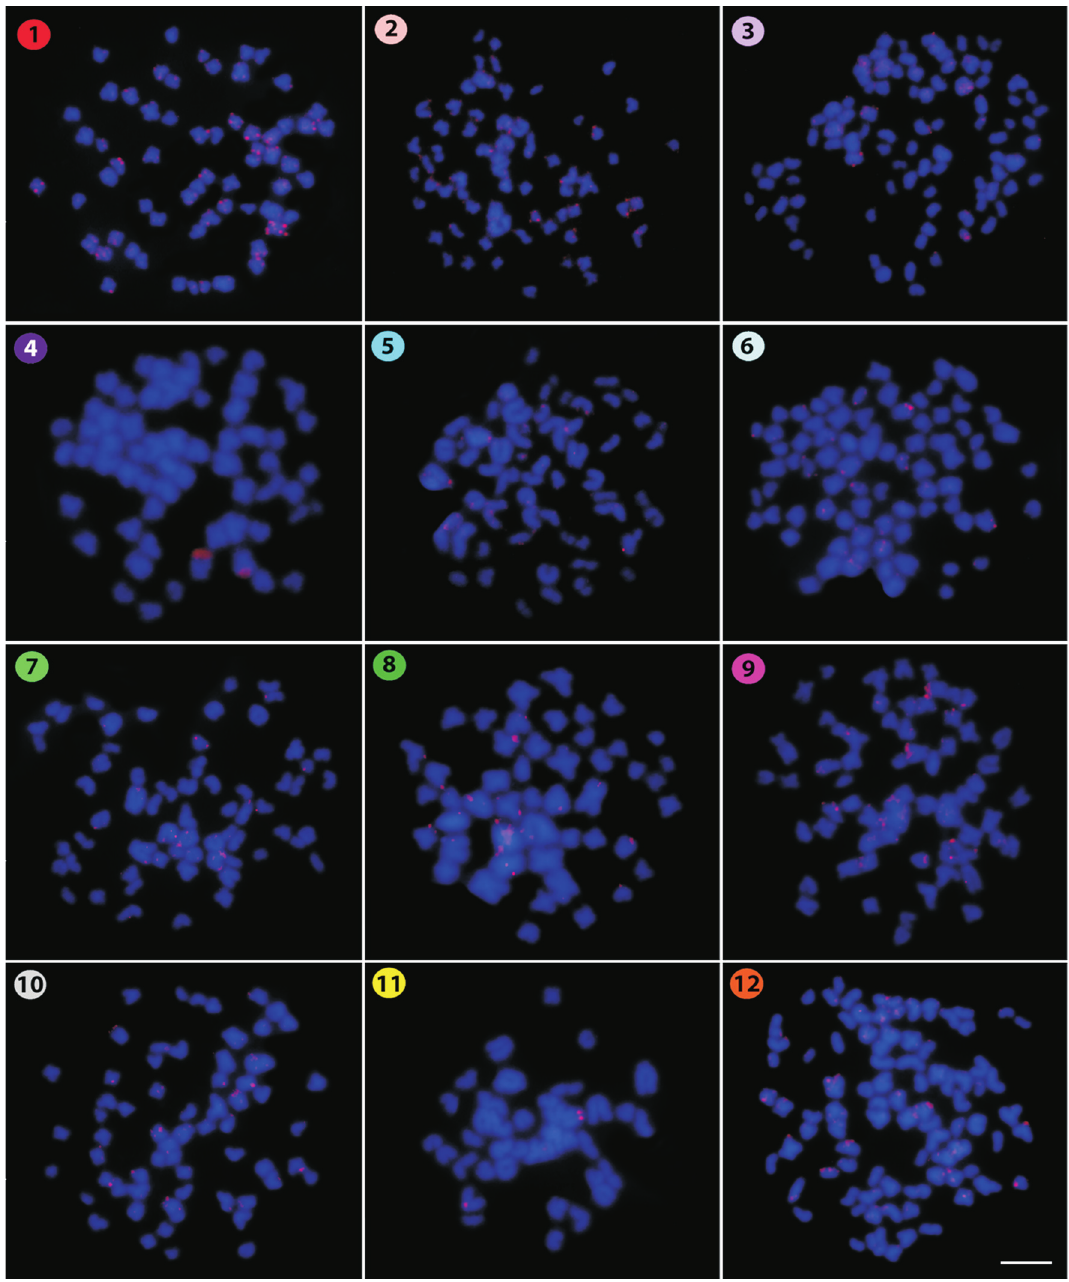
Figure 5 - Hybridization pattern of the (GC) 15 microsatellite probe (in red) on metaphase plates of Belodontichthys truncates ( 1 ); Kryptopterus bicirrhis ( 2 ); Kryptopterusgeminus ( 3 ); Kryptopteruslimpok ( 4 ); Kryptopterusmacrocephalus ( 5 ); Micronemachevevi ( 6 ); Ompokfumidus ( 7 ); Ompoksiluroides ( 8 ); Phalacronotus apogon ( 9 ); Phalacronotus bleekeri ( 10 ); Silurichthys phaiosoma ( 11 ) and Wallago attu ( 12 ). Scale bar = 5 (cid:2)